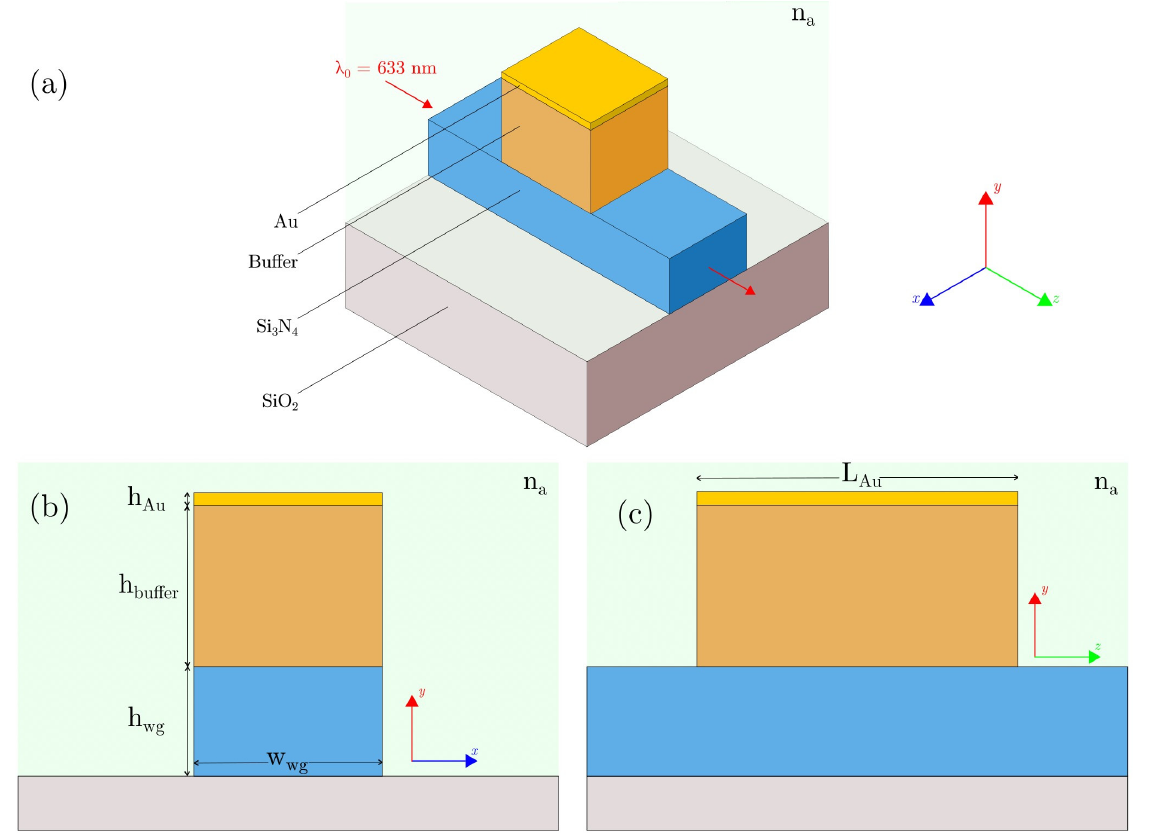
Figure 1. ( a ) Conceptual schematic of the long-range surface plasmon polariton (LRSPP) on-chip waveguide sensor. ( b ) Cross-sectional dimensions for the sensor. ( c ) Longitudinal dimensions for the Cytop and Au layers.